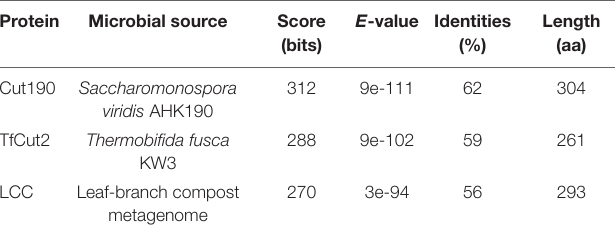
TABLE 3 | Sequence similarities between BgP (290 aa) and bacterial polyesterases of interest for PET biorecycling, generated by a BLASTP search of annotated B. ginsengisoli B129SM11